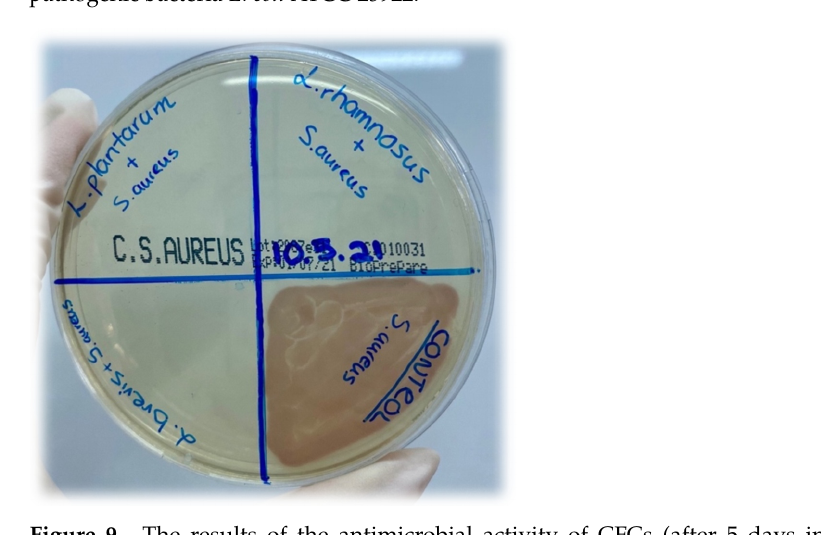
Figure 8. The results of the antimicrobial activity of CFCs (after 5 days incubation) of three LAB species ( Levilactobacillus brevis, Lactiplantibacillus plantarum, Lacticaseibacillus rhamnosus ) against pathogenic bacteria E. coli ATCC 25922.